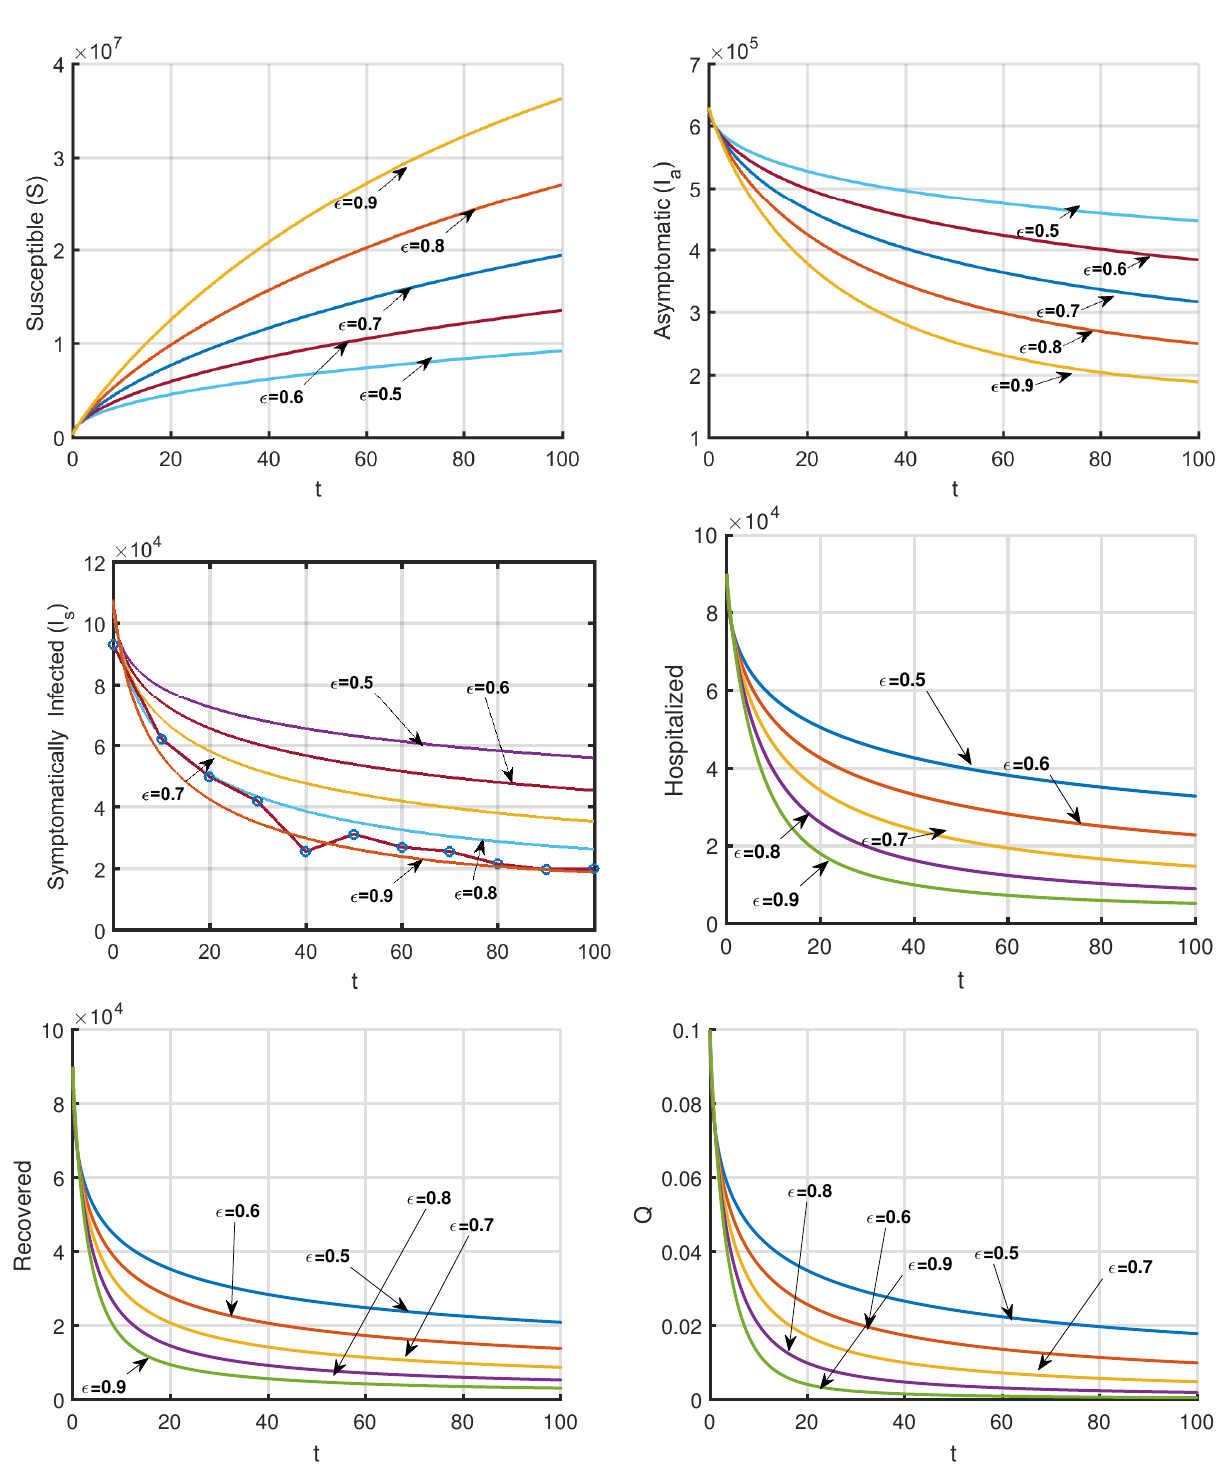
Figure 5. Variation time series with different values of ε